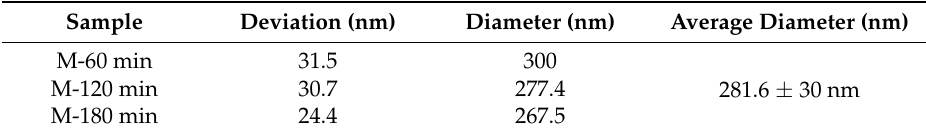
Figure 3. CNC particle size during magnetic stirring. Size distributions with average diameters are shown for dispersion times of ( a ) 60 min, ( b ) 120 min, and ( c ) 180 min. ( d ) TEM image of particles dispersed for 180 min. Table 5. Analysis of CNCs dispersed by magnetic stirring for different dispersion times.